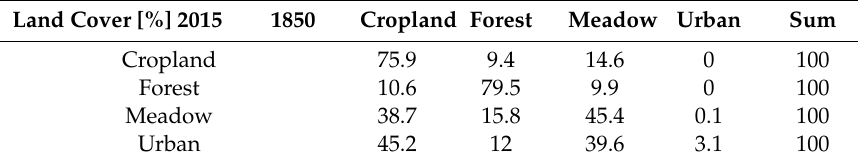
Table 5. Spatially explicit historical origin of today’s land cover assessed in percent.